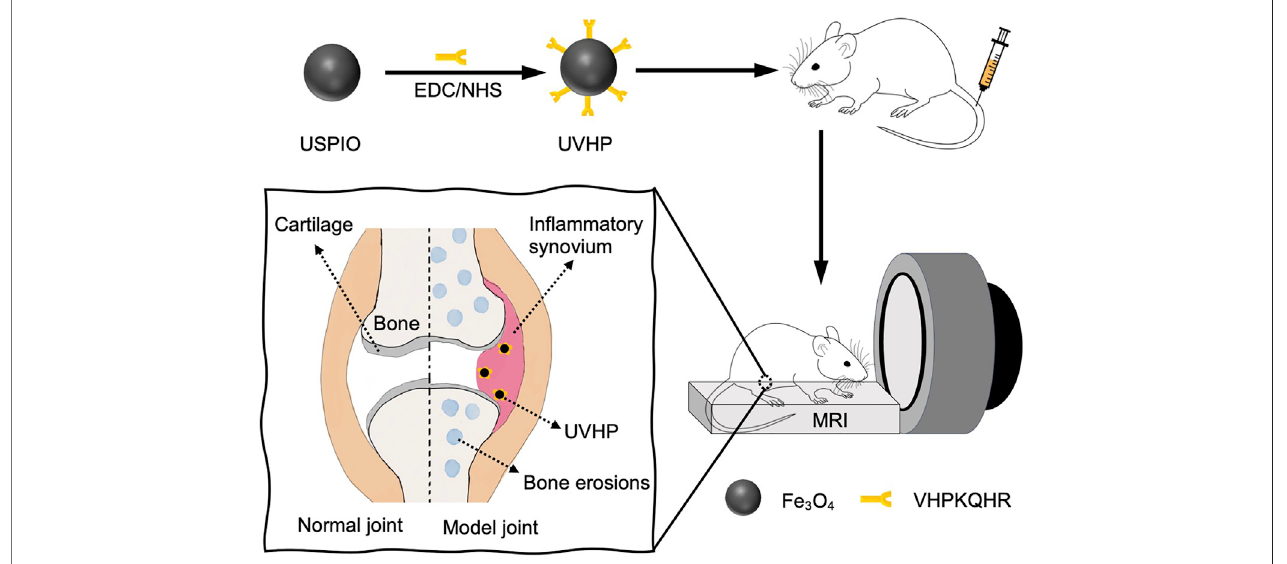
FIGURE 1 | Schematic illustration of the preparation and targeting rheumatoid arthritis of